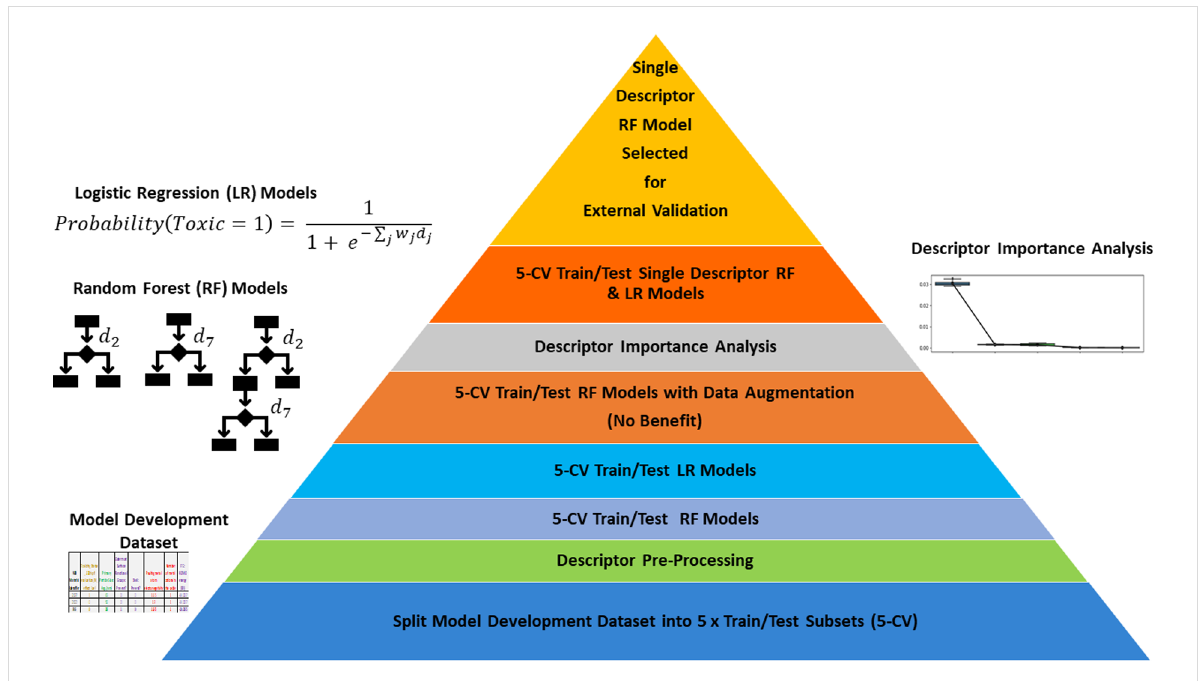
Figure 3: A summary of all modelling work carried out using the model development dataset reported herein. A schematic of the Random Forest modelling technique is provided, illustrating how different descriptors ( d j , j = 1, 2, 3, …) are selected at each node to best separate toxic from non-toxic ENMs based upon random subsets of the available training data and, at each node, the available descriptors. In reality, the depth of the trees may be greater than shown here and several hundred trees were investigated, with the precise number being one of the investigated hyperparameters tuned using the training data. For logistic regression, each descriptor is assumed to make an independent contribution, according to corresponding weights ( w j ), to the probability of the ENM being toxic. Both kinds of model, using either all available descriptors or a single descriptor identified via subse- quent descriptor importance analysis based upon the entire model development dataset, were evaluated on the model development set using nested fivefold cross-validation (5-CV) to minimize optimistic bias in the evaluation of model performance – although the estimated performance of the selected single descriptor model may suffer more from optimistic bias. Unless noted otherwise, data augmentation was not used to enhance the data used for training the